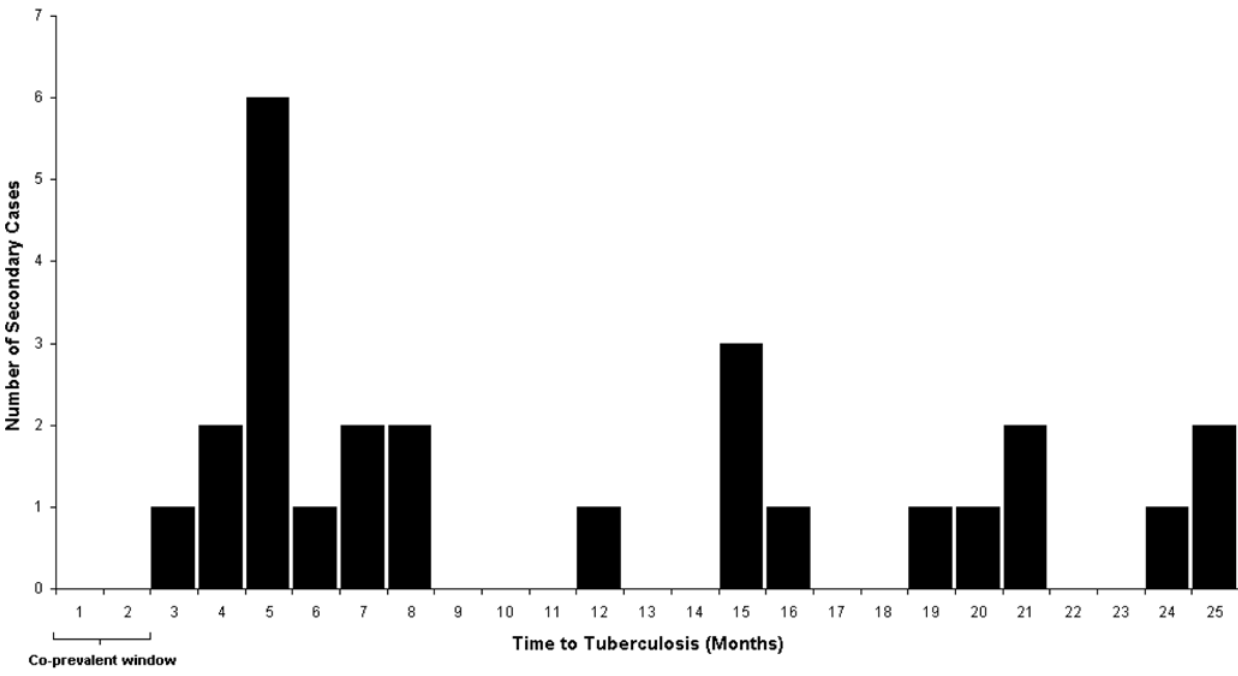
Figure 2. Timing of presentation for diagnosis of incident TB cases after exposure to their respective index case.